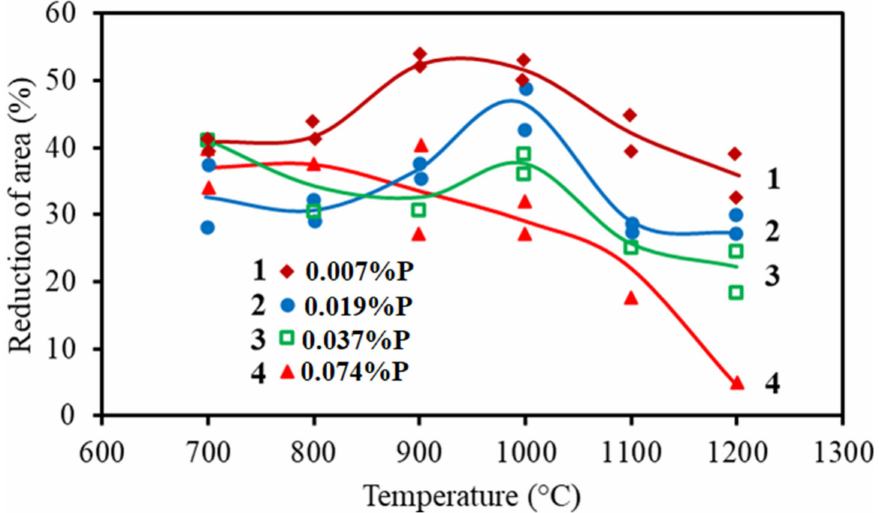
Figure 22. Influence of P on hot ductility curves of a TWIP steel. Steels had a base composition of 0.6% C, 0.3% Si, 18.2% Mn, 0.005% S, 1.5% Al, 0.01% Ti, 0.007% N with a B addition of 0.0026% B and P additions of 0.007, 0.019, 0.037 and 0.074%, steels, 1–4, respectively